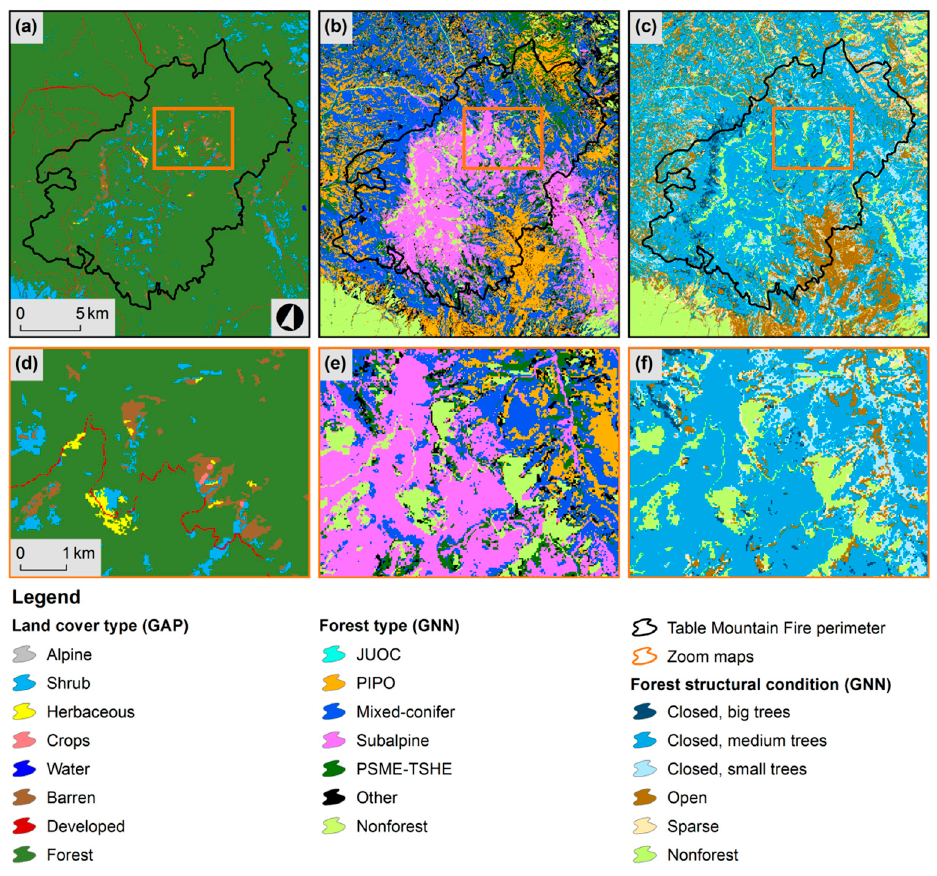
Figure 4. Spatial patterns of pre-fire land cover ( a , d ), forest type ( b , e ), and forest structural condition ( c , f ) across the 2012 Table Mountain Complex. Fire location is indicated in Figure 1. The 2003 GNN-based forest maps ( b – e , f ) illustrate more variability in forest type across this plateau landscape than in forest structure, which was generally closed-canopy forest dominated by medium trees (see Section 2 for classification details). Zoom maps ( d – f ) show how fine-grained variability of pre-fire conditions. Data sources and references: GAP (Gap Analysis Program) land cover: https://gapanalysis.usgs.gov; GNN (gradient nearest-neighbor imputation) based on Ohmann et al. [38]. See Supplemental Figures